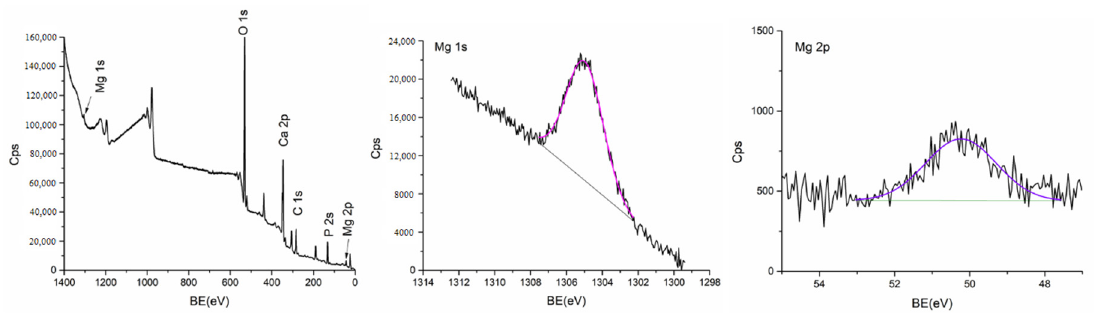
Figure 15. The XPS survey spectrum of the 25MgHAp coatings. High resolution Mg 1s ( a ) and Mg 2p ( b ) spectra of 25MgHAp coatings.